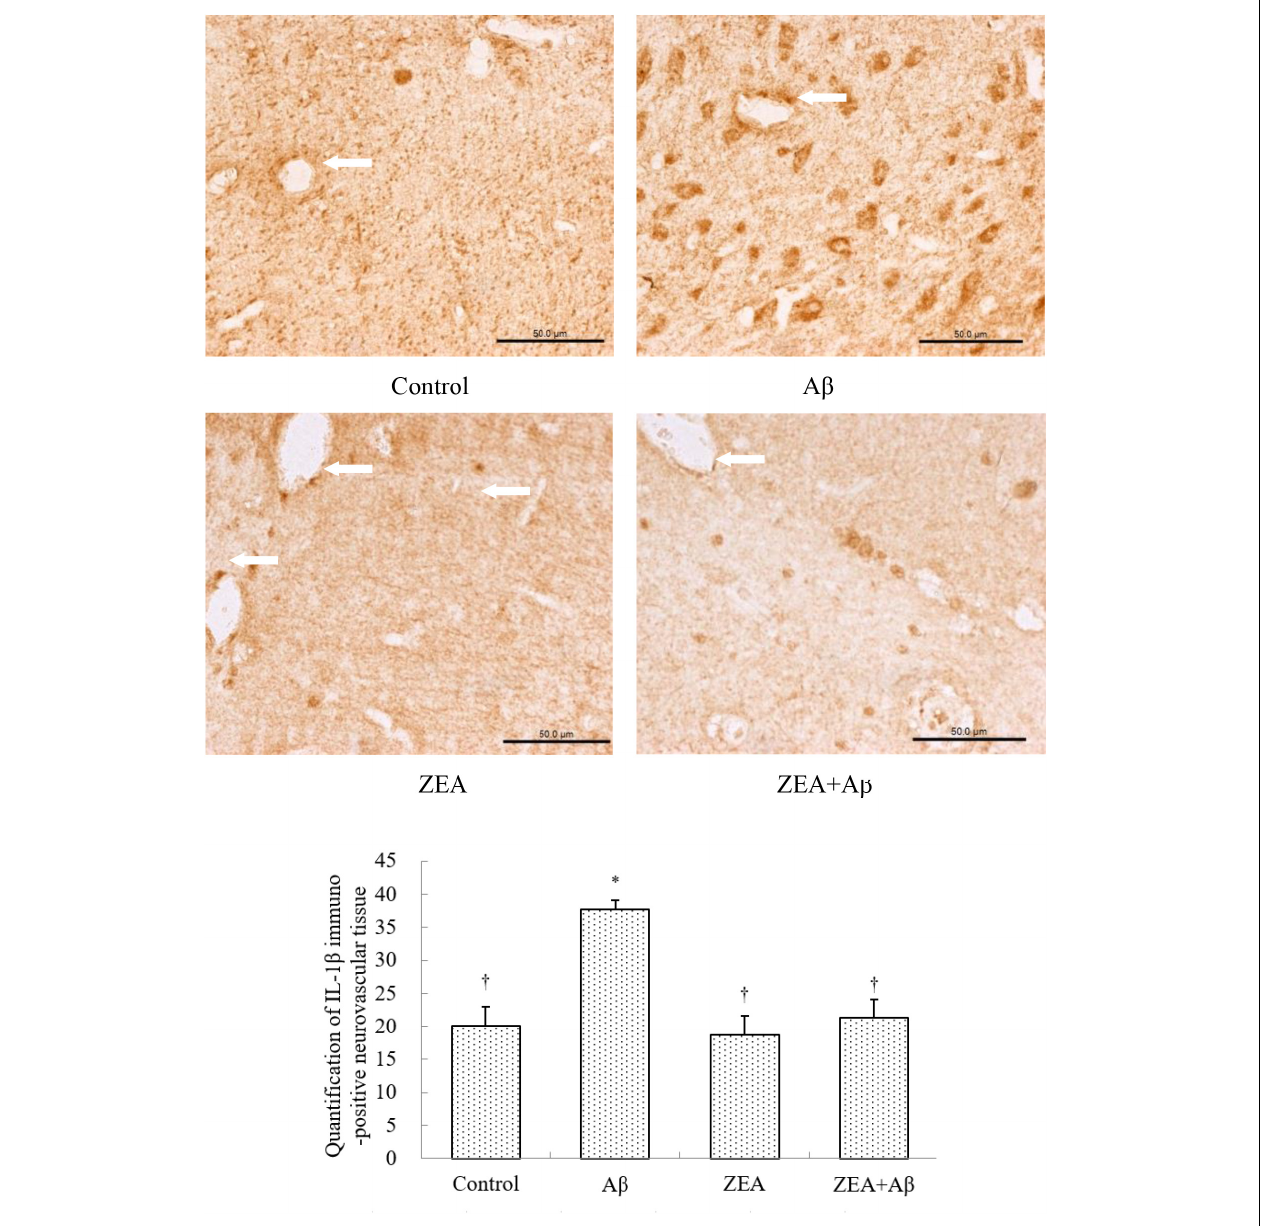
FIGURE 9 | Neuroprotective effects of ZEA on IL-1 β in cerebrovascular tissue of learning and memory impairment rats induced by A β 1–42. Immunohistochemistry was used in the paraffin section of the whole rat brain from four treatment groups mentioned before ( n = 12 per group). All the data were shown as mean ± SD, and analyzed by the one-way ANOVA test [ post hoc (LSD) test]. ∗ Significantly different from the Control group ( p < 0.05). † Significantly different from the A β group ( p < 0.05). Staff gauge showed 50 µ m at the right side of every pictures’